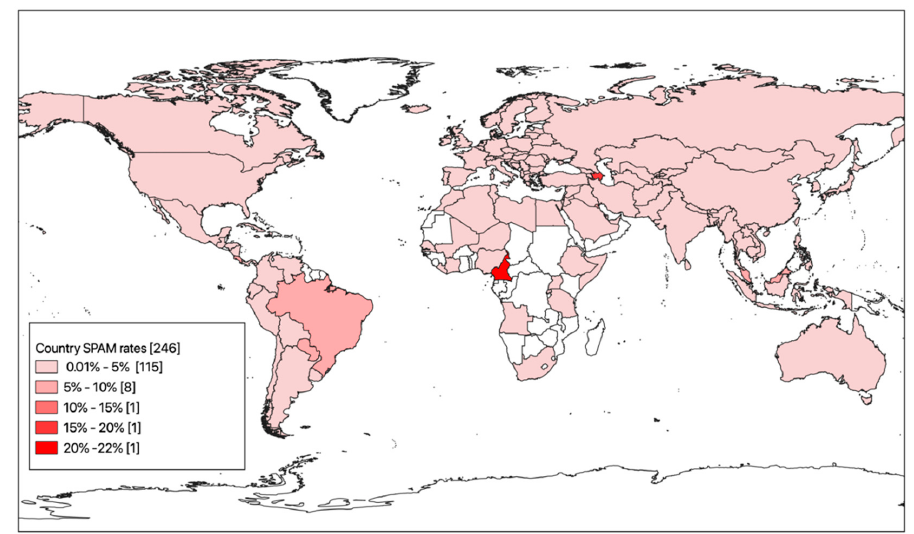
Figure 13 . Distribution rates of OSM Notes include of SPAM keyword.